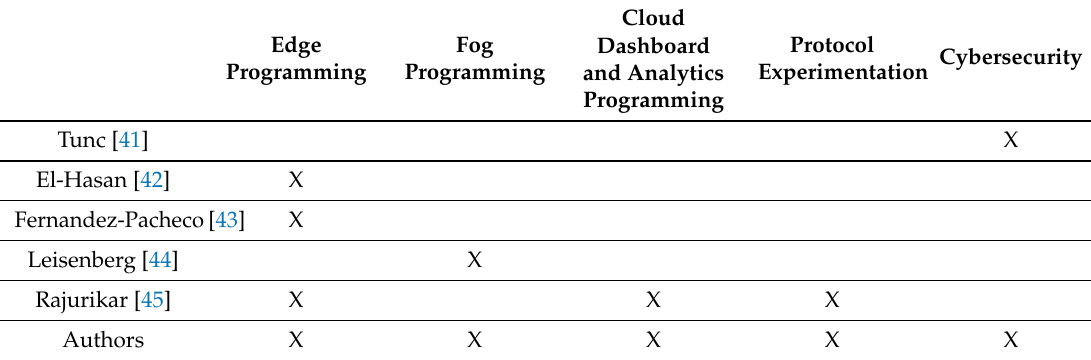
Table 1. Functionality comparison of the state of the art on IoT remote